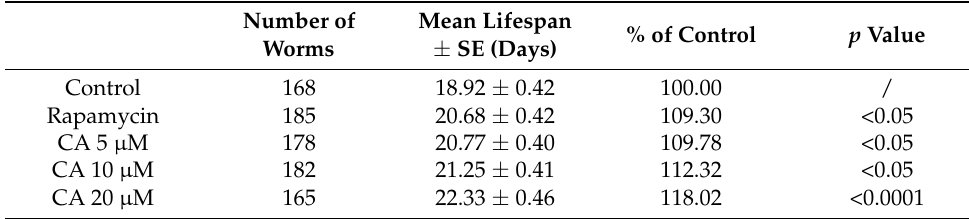
Table 2. Effect of CA on the mean lifespan of C. elegans .